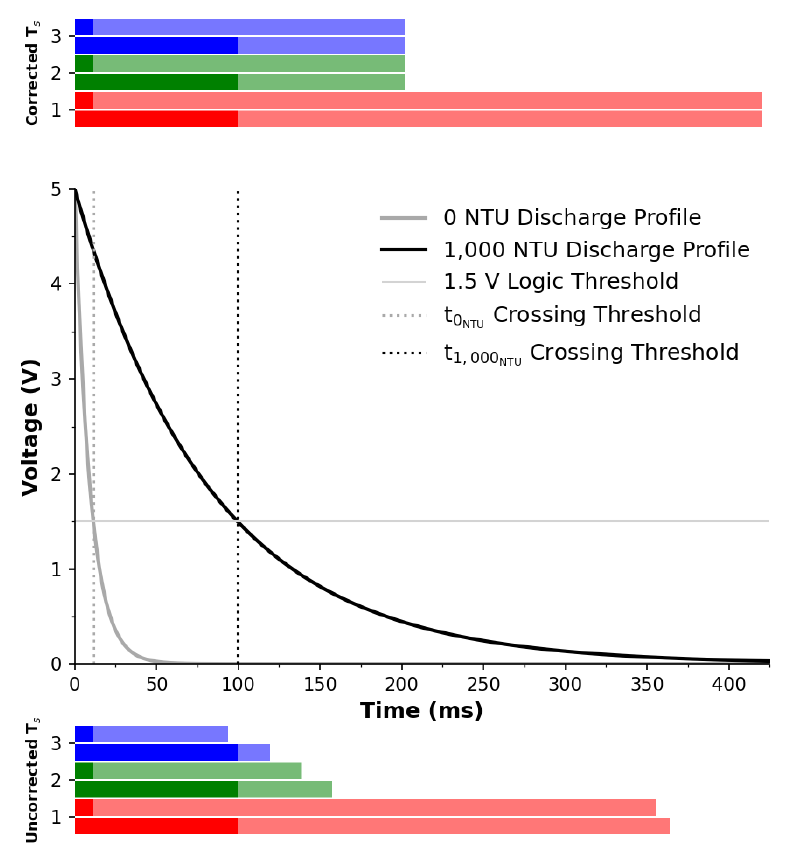
Figure 7. Time domain view of the 0 and 1000 NTU measurements. The full width of the bars show the sampling period. The pronounced color area of the bars indicates the turbidity concentration. Top : Corrected sampling period approach. Middle : Extrapolated discharge profiles with logic and crossing thresholds. Bottom : Uncorrected sampling period approach. Colour key: Method 1 (red), Method 2 (green), Method 3